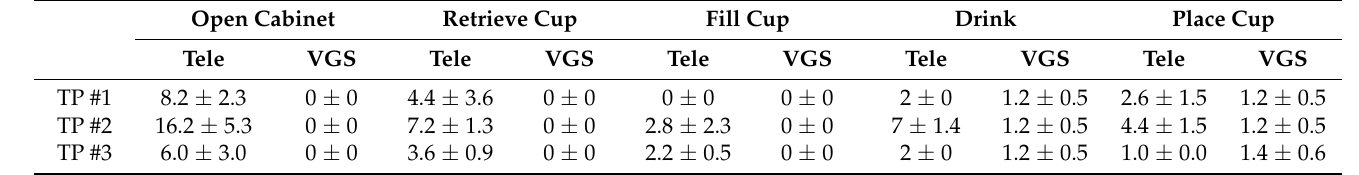
Table 5. Subtask joystick mode-switch frequency during teleoperation and VGS control.